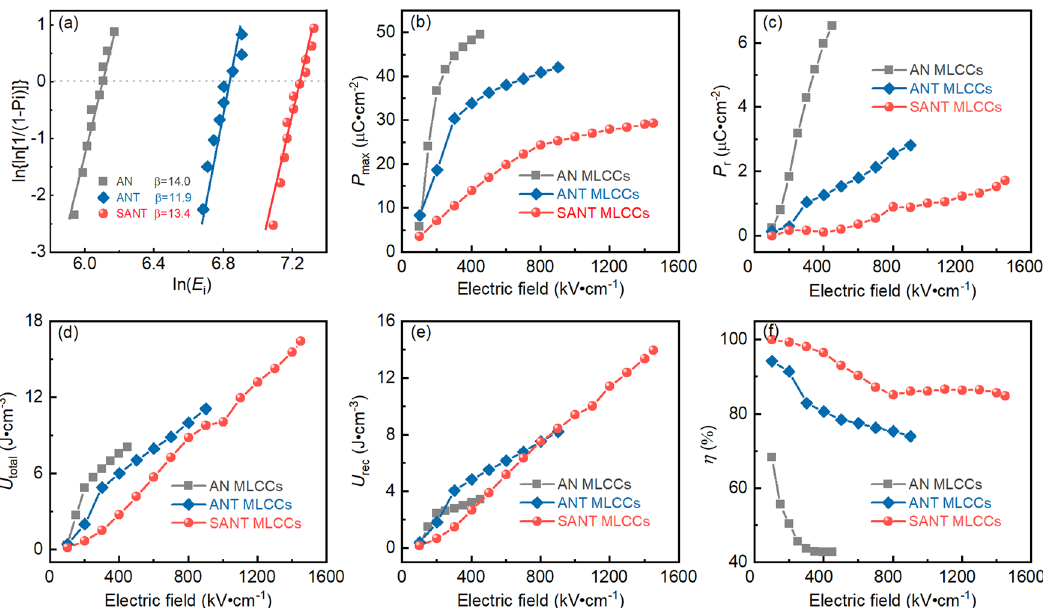
Fig.5|TheBDS,andferroelectricandenergystorageperformancesofAN,ANT, and SANT samples. Weibull plots of DBS ( a ), the detailed variations of P max ( b ), P r